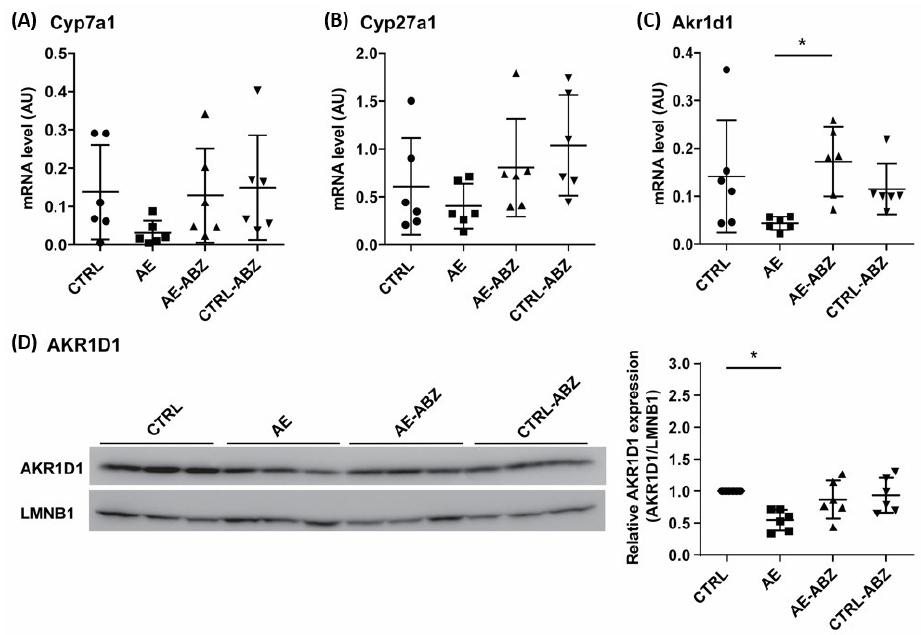
Figure 3. Expression levels of enzymes involved in bile acid synthesis. The mRNA levels of Cyp7a1 ( A ), Cyp27a1 ( B ), and Akr1d1 ( C ) and the protein levels of AKR1D1 ( D ) were determined in the liver tissues of non-infected control (CTRL, n = 6), E. multilocularis -infected (AE, n = 6), E. multilocularis - infected and ABZ-treated (AE-ABZ, n = 6), and non-infected and ABZ-treated control mice (CTRL-ABZ, n = 6). One representative blot (of two) containing samples from three different mice is shown in ( D ) on the left and densitometry results are shown on the right, representing data from the two blots on samples from six mice, normalized to lamin B1 (LMNB1) control and with CTRL set as 1. Values are expressed as mean ± SD. * p < 0.05.